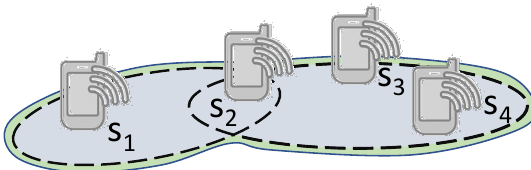
Figure 13. Example of clique